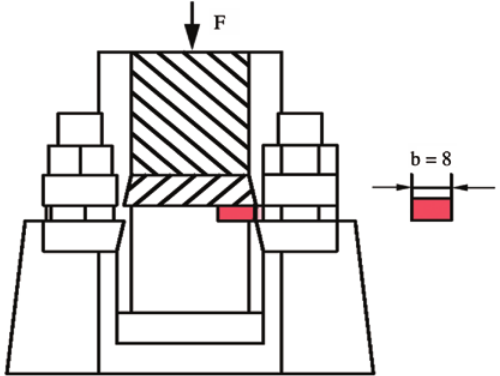
Figure 8: Fracture morphology of NiCrSiBFeTi brazed joint: (A) macroimage; (B)